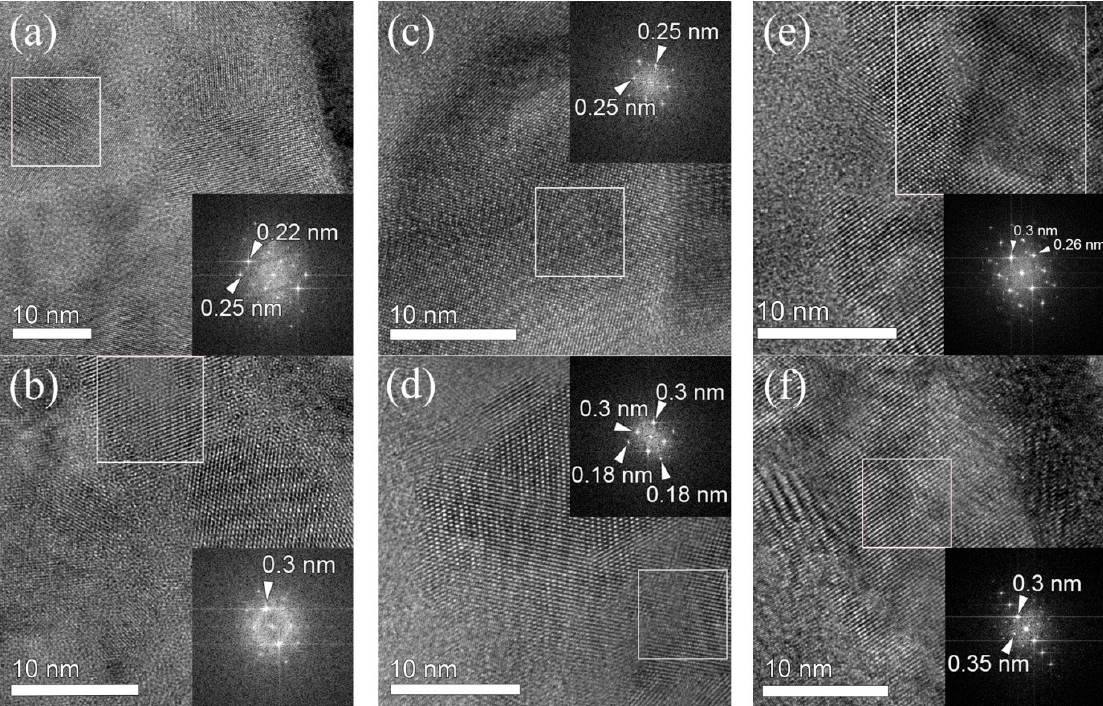
Figure 5. TEM images of ZrO 2 films grown at ( a , b ) 250 °C, ( c , d ) 300 °C, and ( e , f ) 350 °C. Inset are corresponding Fourier transforms obtained from the areas indicated by squares.